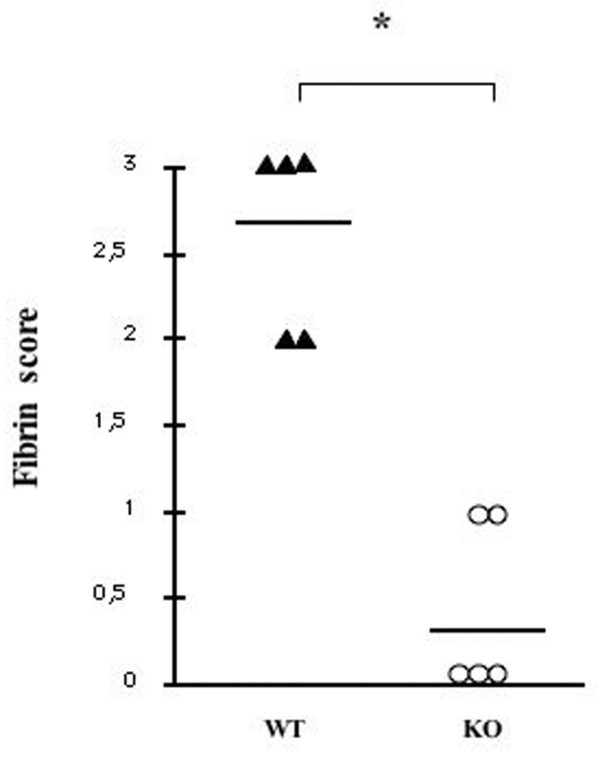
Role of fibrin in soluble tissue factor-induced inflammation. Fibrin immunohistochemical scores in protease activated receptor PAR-4-/- mice (WT) compared with control mice (KO). *P = 0.001, Wilcoxon rank sum test. WT, wildtype; KO, knockout.